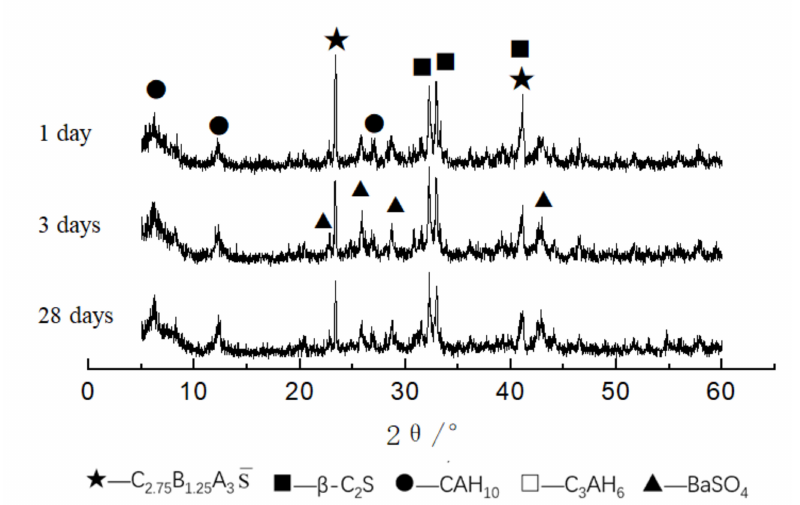
Figure 17. XRD patterns of sample CF5 at different hydrated